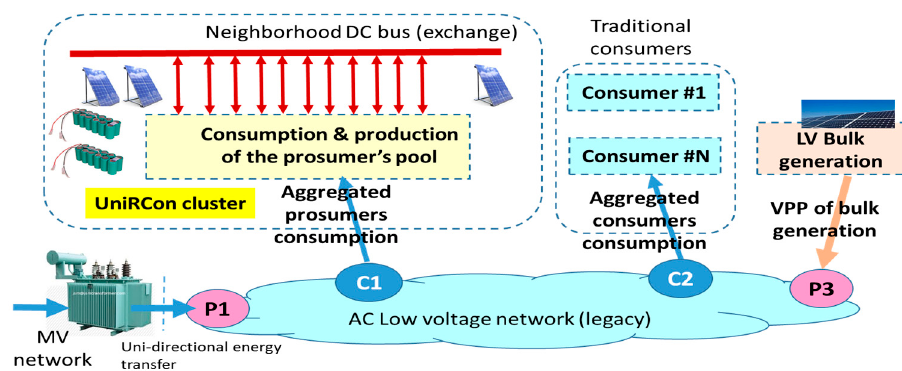
Figure 11. An operation with increased network security, by having a reduced number of energy injection points in the network and with the potential of increasing main-grid resilience through “friendly” connected UniRCon clusters.